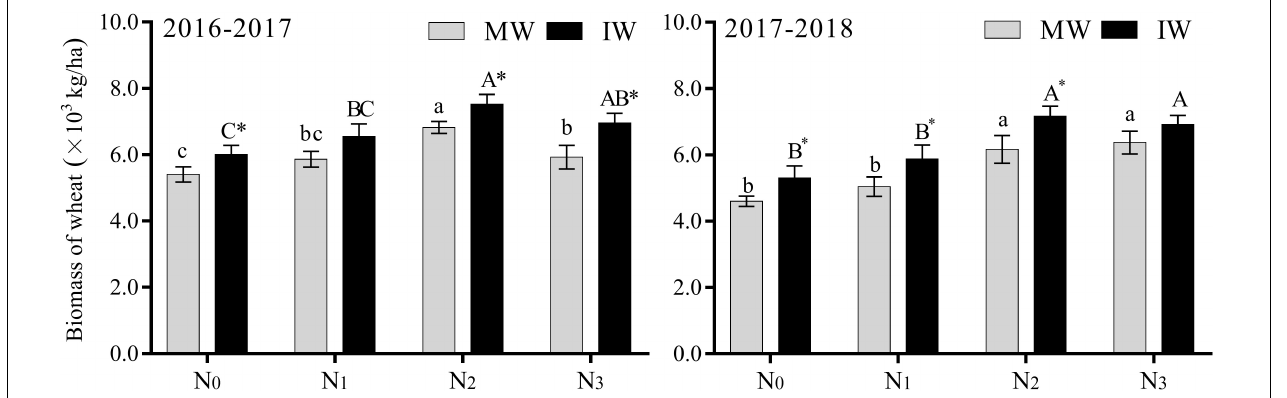
FIGURE 5 | Effects of applied nitrogen and intercropping on wheat biomass at the filling stage. MW, monocropped wheat; IW, intercropped wheat; M, middle of canopy; B, below of canopy. The different capital letters and small letters represent significant differences between different N levels in the same planting pattern at P < 0.05 levels. * Represents significant difference between monocropped and intercropped patterns at the same N level ( P <